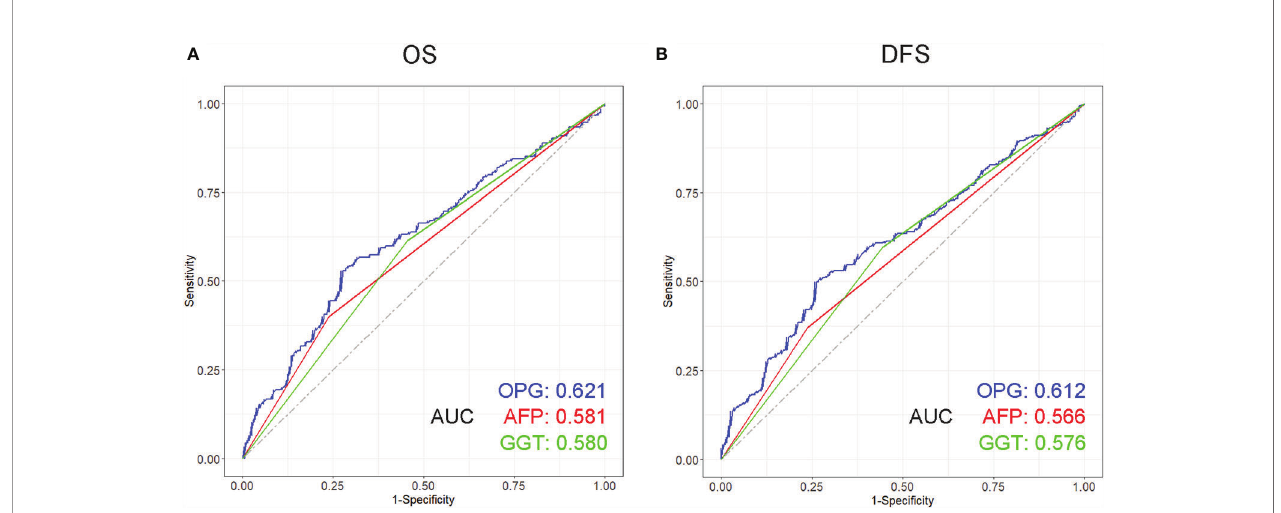
FIGURE 7 | Receiver operating characteristic (ROC) curve of OPG, AFP and GGT in terms of OS (A) and DFS (B) and its corresponding